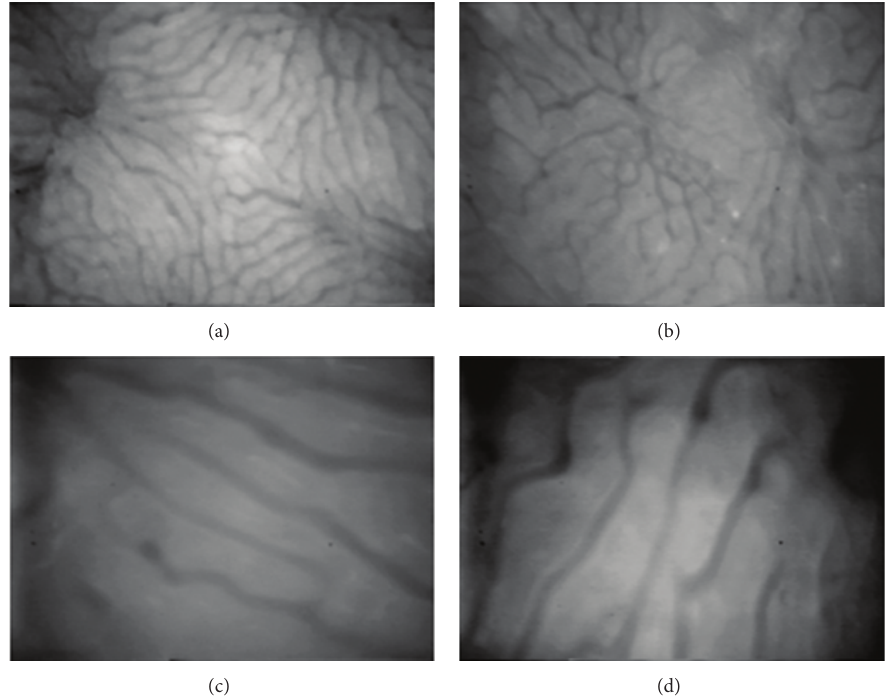
Figure 1: Representative intravital fluorescence microscopic images of the retinyl ester auto-fluorescence ((a) and (b)) and sinusoidal architecture ((c) and (d)). Liver from calorically restricted mice (a) shows diminished spots and intensity of vitamin A auto-fluorescence compared with control liver (b); the calorically restricted liver also has homogenous sinusoids (c) while the unrestricted liver contains more torturous sinusoids (d). Animal age is 14 months. The magnification is 20x ((a), (b)) or 100x ((c), (d)).